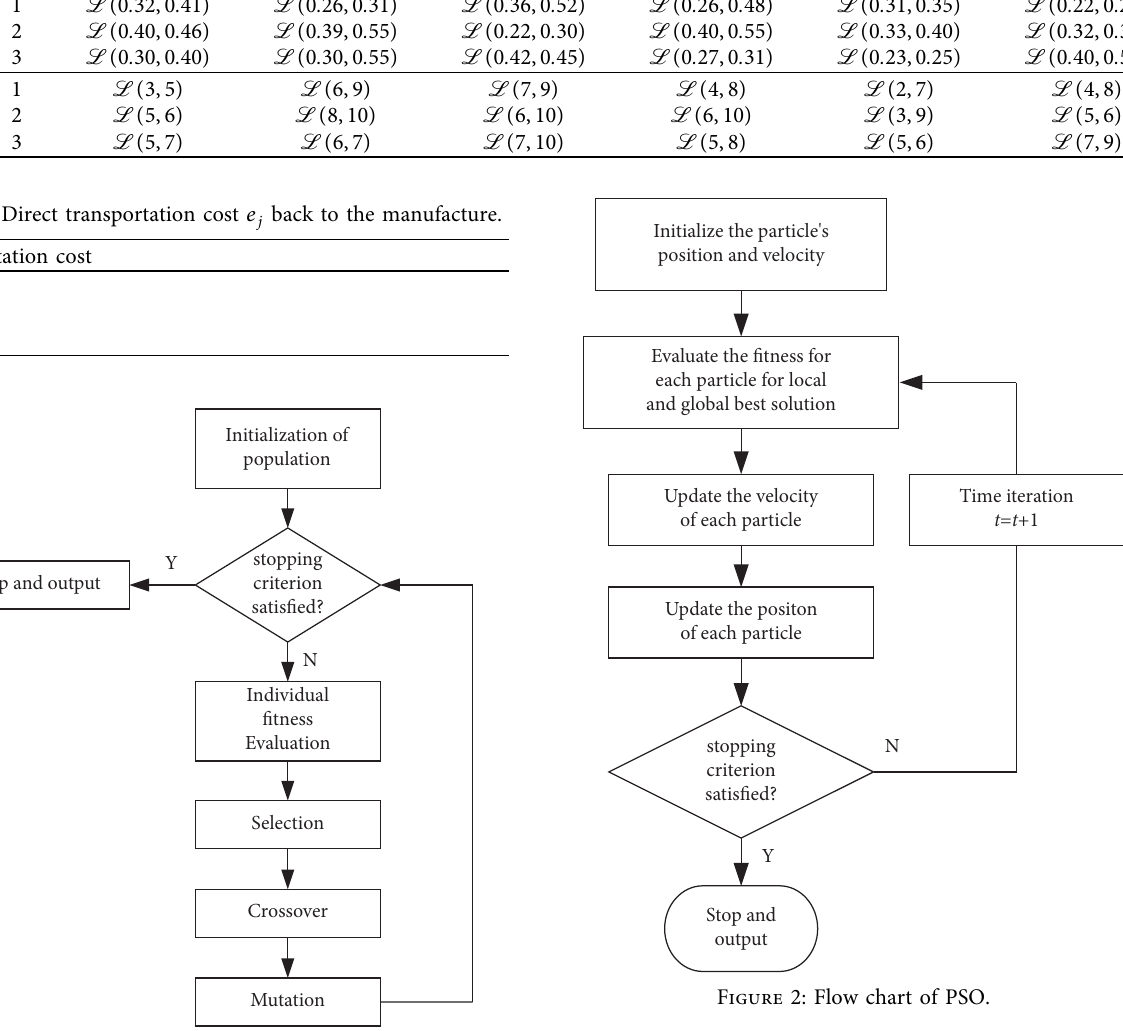
Figure 1: Flow chart of GA.